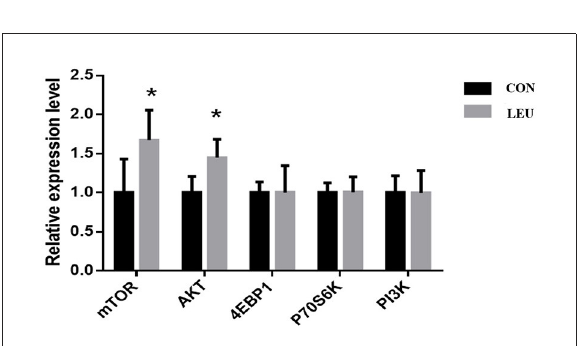
FIGURE5 Effects of dietary leucine supplementation on expression of mTOR signaling pathway-related genes in the testis of boars. CON, control group; LEU, leucine group. Values are means, with their standard errors represented by vertical bars ( n = 15), * means P < 0.05. mTOR, mammalian target of rapamycin; AKT, protein kinase B; 4EBP1, 4E-binding protein 1, Eukaryotic translation initiation factor 4 binding protein; P70S6K, p70 ribosomal protein S6 kinase; PI3K, creatine inositol 3